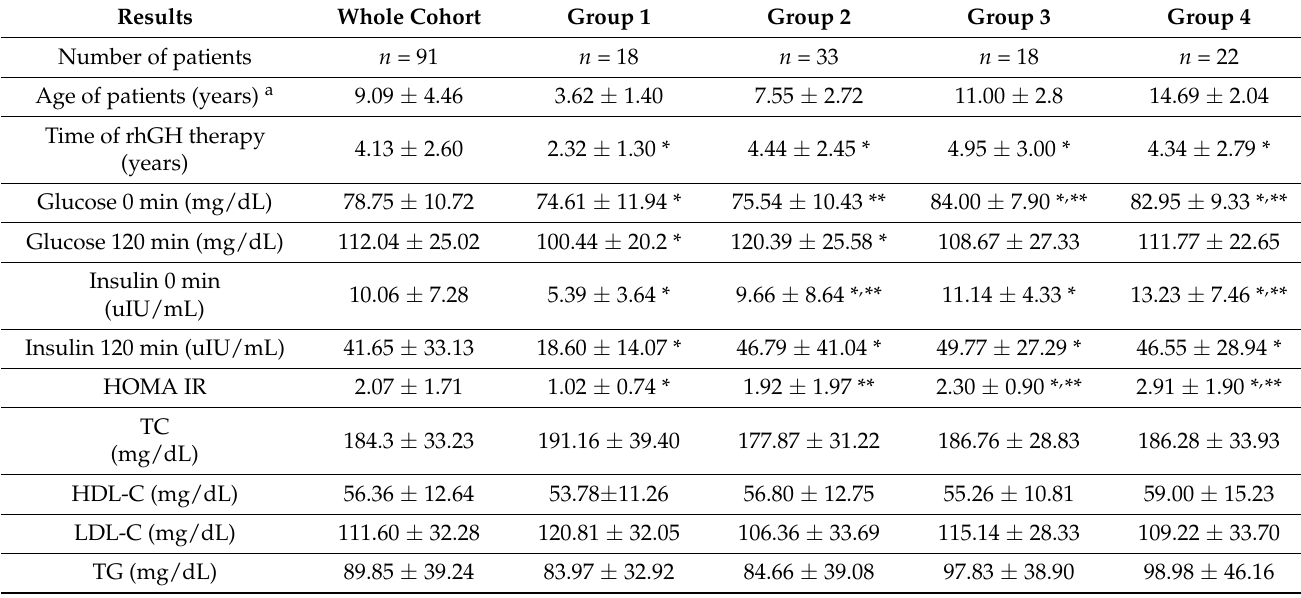
Table 4. Metabolic assessment: insulin and glucose in the OGTT, HOMA-IR and lipid profile (mean value ± standard deviation score (SDS)).